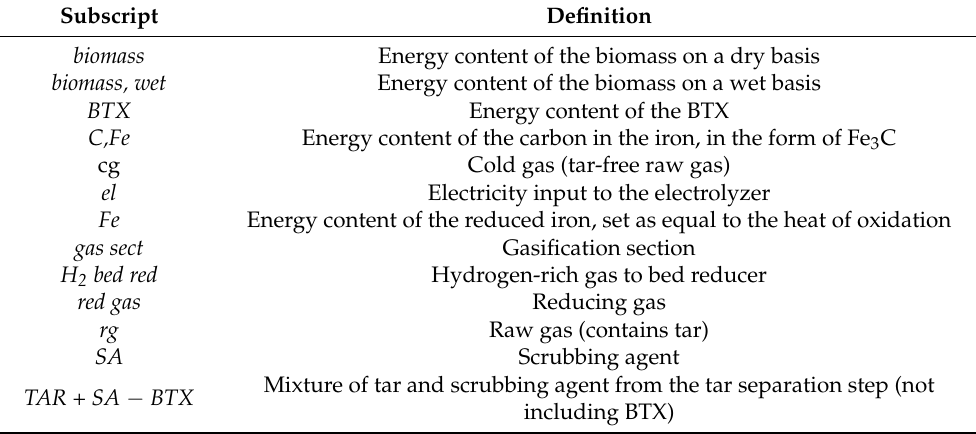
Table 4. Definitions of the subscripts used in the definitions of the efficiency performance indicators in Table